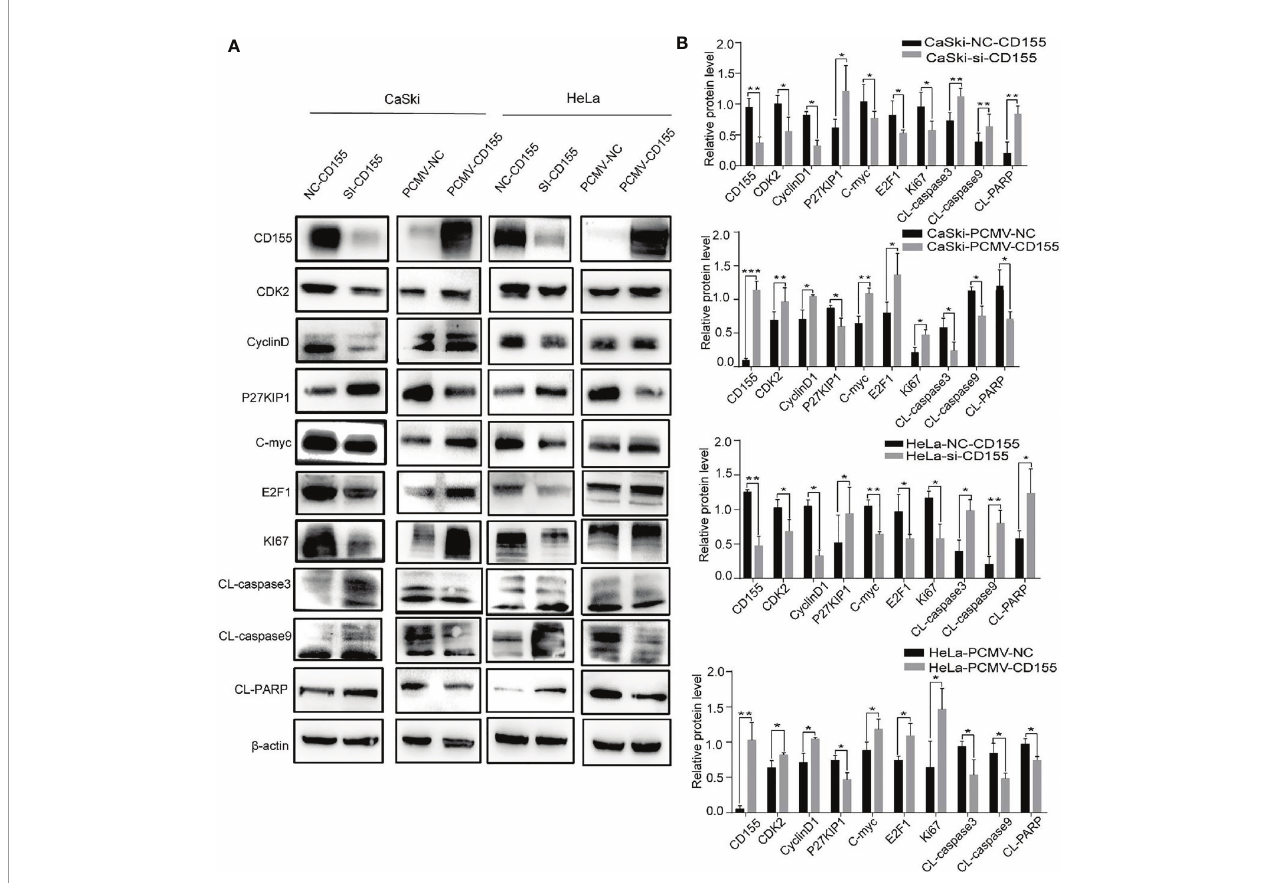
FIGURE 3 | CD155 affects the expression of cell cycle- and apoptosis-related proteins in CaSki and HeLa cells. (A) After transfecting CaSki and HeLa cells with NC-CD155, si-CD155, PCMV-NC, or PCMV-CD155, the protein expression levels of CD155, CDK2, CyclinD1, P27KIP1, C-myc, E2F1, Ki67, CL-caspase3, CL- caspase9 and CL-PARP were analyzed by western blot. b -actin as a control. (B) Quantitation of the bands shown in (A) using Image J The data are the mean ± SEM of at least three independent experiments. *P < 0.05, **P < 0.01, and ***P <